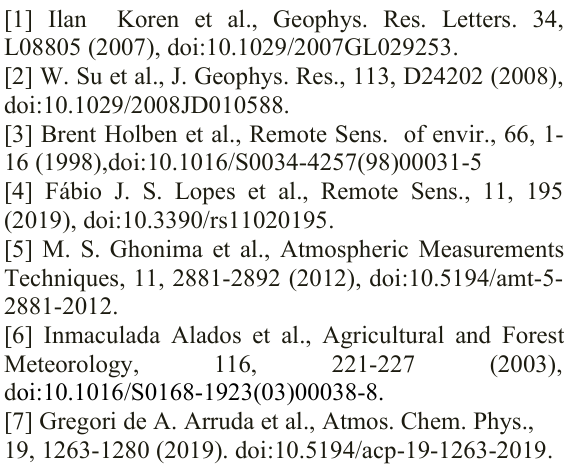
Figure 5: RBR-AOD at 532 nm correlation for 10 th of April for Sun zenith angles between 30 0 and 70 0